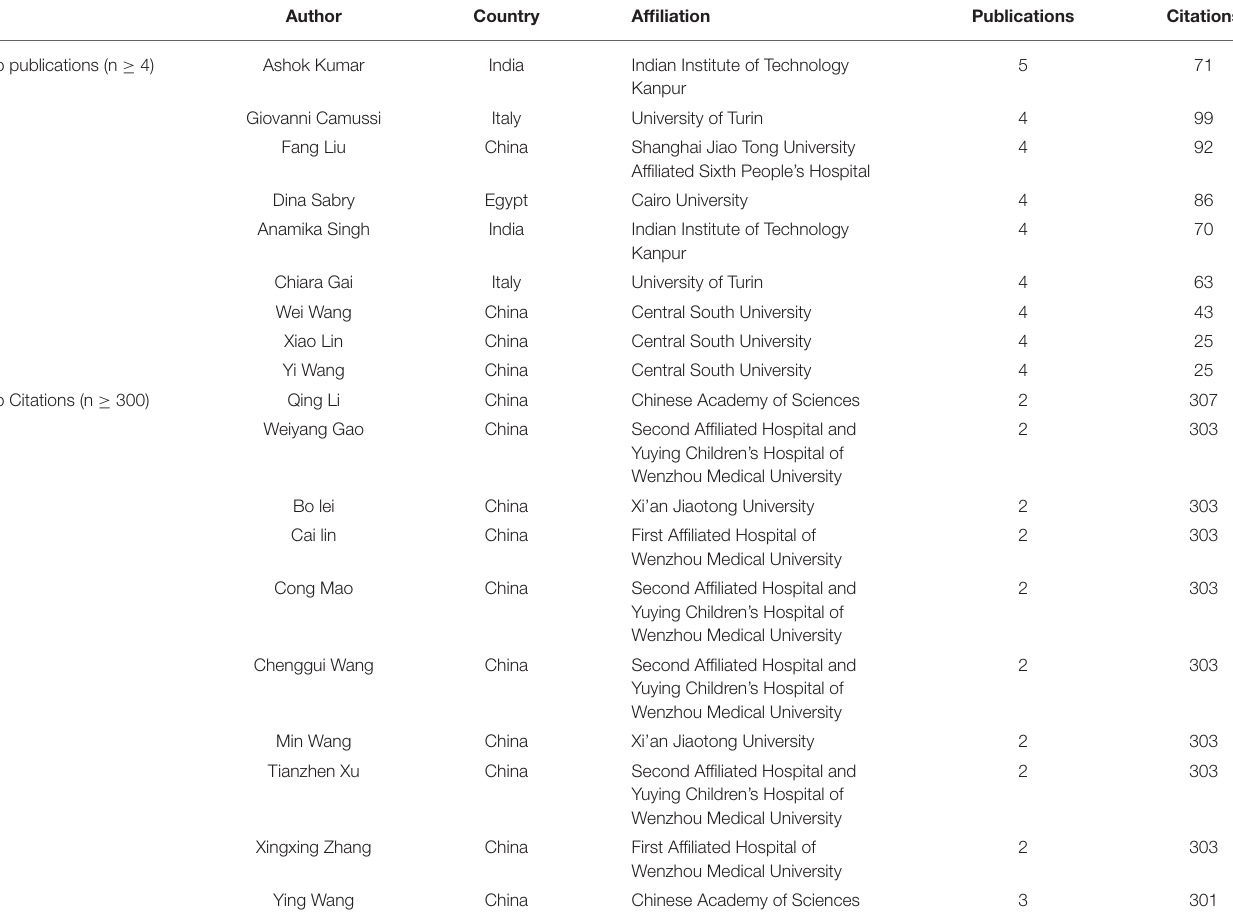
TABLE 4 | The top authors in the field of SC-EVs for diabetes ranked by publication and citation